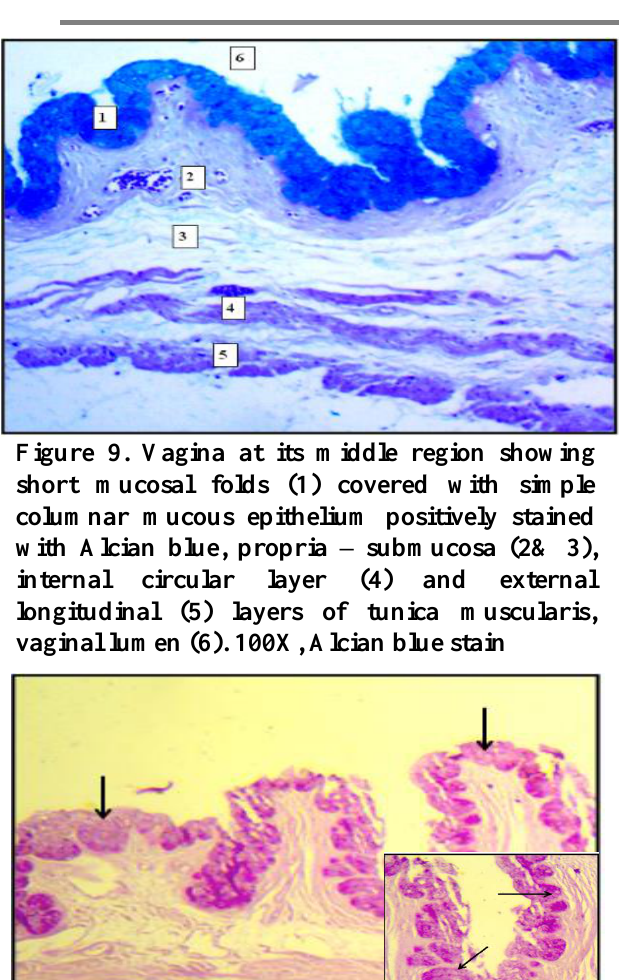
X4 X10 Figure 10. Vagina at its middle region showing short mucosal folds covered with simple columnar mucous epithelium positively stained with PAS (black arrows)